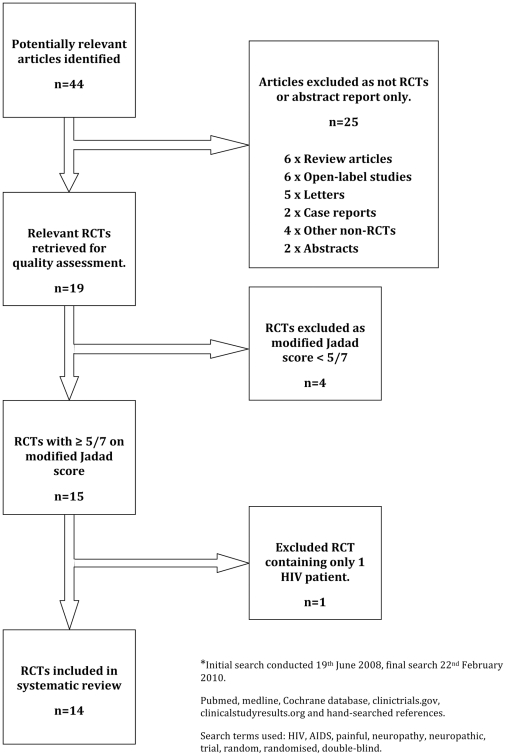
PRISMA flow diagram of included randomized controlled trials.